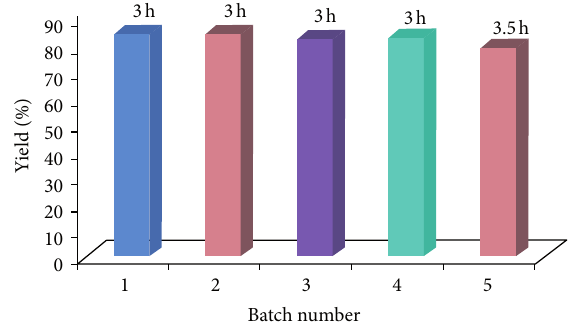
F 1: Study of catalyst